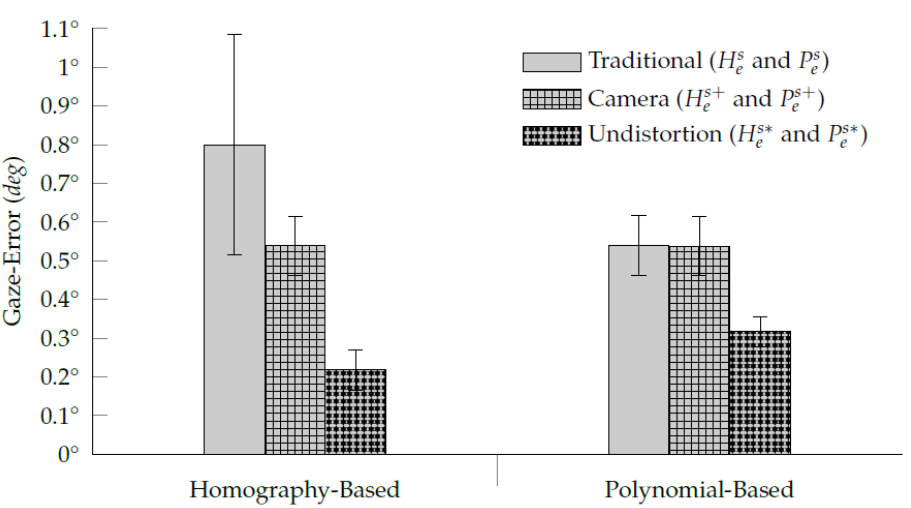
Figure 11. The average gaze-error distribution of simulated eye-tracking data analysis. The bar plots show the improvements achieved with the proposed eye-camera location compensation ( H s + e and P s + e ), and proposed eye feature distribution undistortion ( H s ∗ e and P s ∗ e ) over the traditional interpolation-based gaze estimation methods ( H s e and P s e ). The large error bar in the traditional homography-based method H s e is due to is sensitivity to the eye-camera location’s influence.